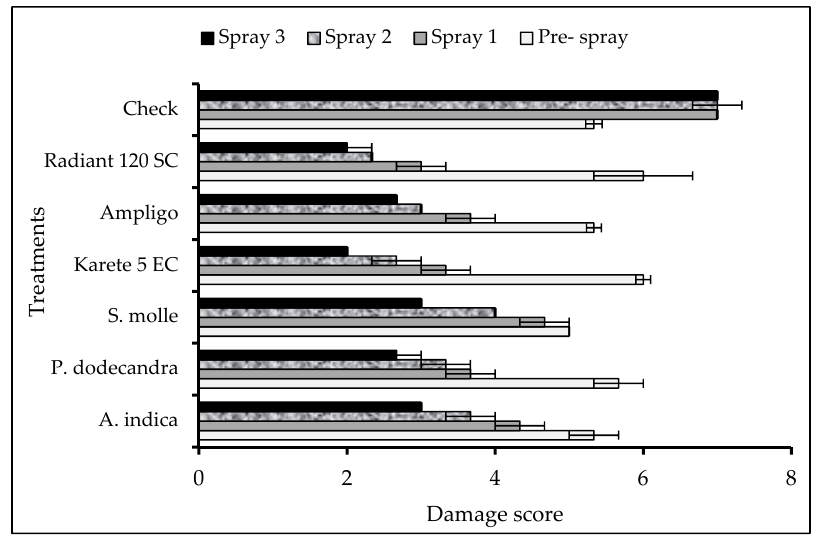
Figure 2. Mean ( ± SEM) of leaf damage of maize by FAW under different treatments in the field. Figure 2. Mean (± SEM) of leaf damage of maize by FAW under different treatments in the field. Table 7. Mean number ( ± SEM) of FAW larvae after treatment application. Table 7. Mean number (± SEM) of FAW larvae after treatment application. Mean Numbers of Live Larvae Mean Numbers of Live Larvae Treatments Treatments Pre-Spray